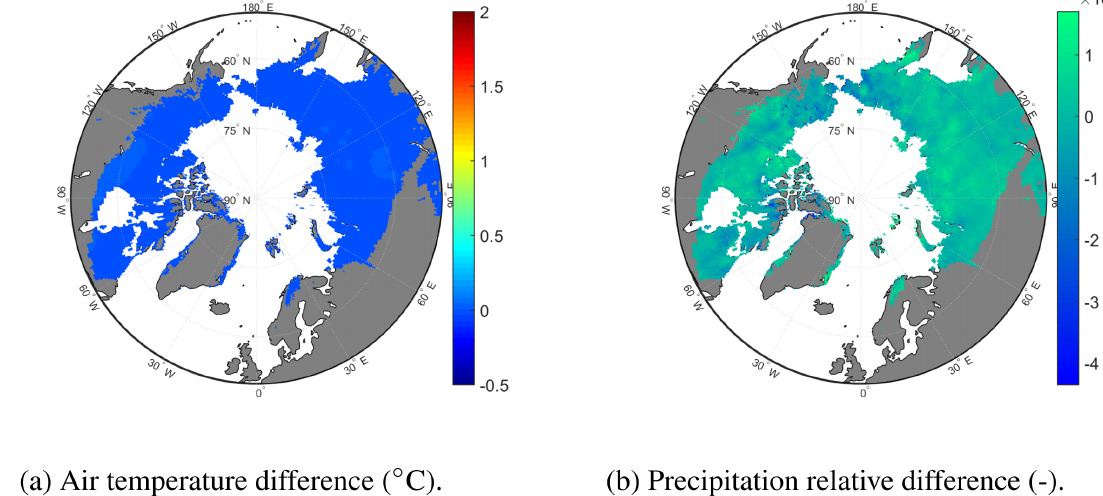
Figure 4. Comparison of 1980–2009 averages of meteorological variables (REDVAR − CNTL) or (REDVAR − CNTL)/CNTL. Air temper- ature colour scale adjusted to Fig. 9.